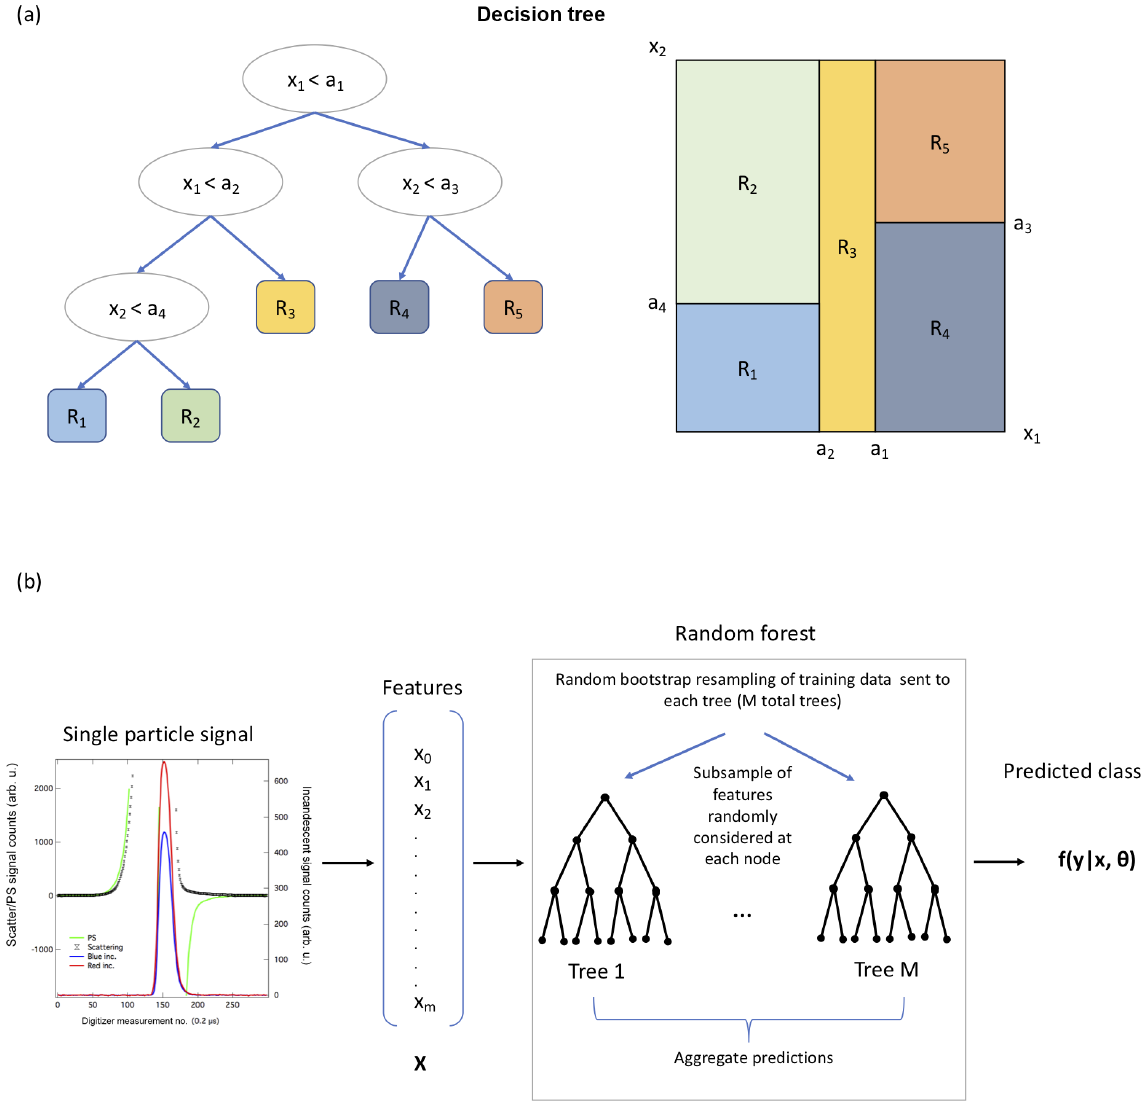
Figure 5. Schematic of a decision tree (a) , and a random forest as applied to the SP2 signals (b) . (a) A simplified example of a decision tree for a case with only two features, demonstrating how choosing threshold values of the features at each node (left) subdivides the feature space into different regions (right). The true case corresponds to the left “child” in the tree. This figure has been adapted from Mohri et al. (2012). (b) The schematic for applying supervised learning to predict the aerosol class for a particle measured by the SP2 is shown. First, single particle signals are processed and reduced to a feature vector x i , which is then given to the trained random forest. Each decision tree within the forest makes a series of decisions based on the values of the features (which have been learned from a random subset of the training data, by considering a random subsets of features at each split) to predict the most likely class of the particle based on the observed features. The aggregated prediction from the ensemble of M decision trees predicts a probability distribution f (y) = p(y | x i ,θ) over each class y